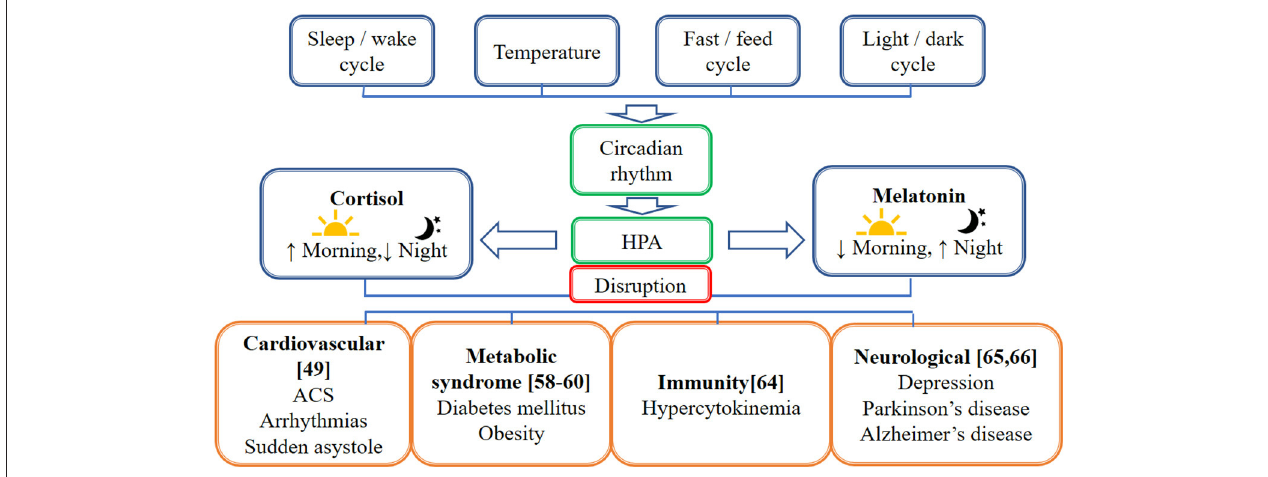
FIGURE 1 | Schematic diagram on the factors affecting the circadian rhythm and the effect of circadian disruption on different body systems. This figure illustrates factors affecting the circadian rhythm which are the sleep/wake cycle, temperature, fast/feed cycle, and light/dark cycle. The hypothalamic-pituitary-adrenal axis (HPA) caused the cortisol to be high in the morning and lower in the night while melatonin is high in the night and lower in the morning. The circadian disruption affects different body systems, including cardiovascular, neurological, immunity, and metabolic functions.